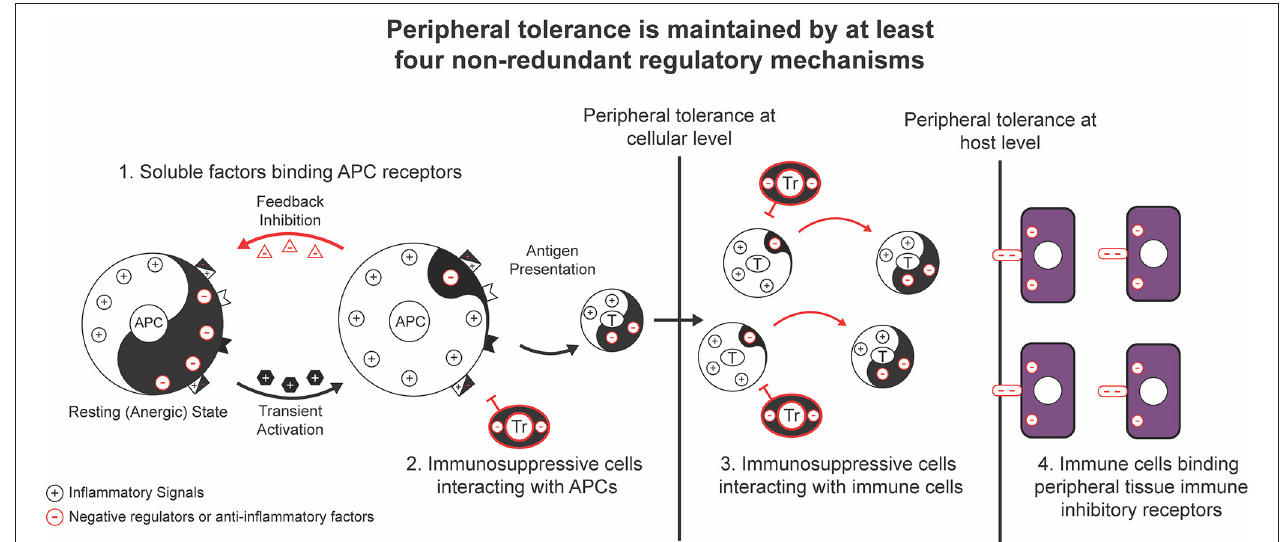
FIGURE 5 | Maintenance of peripheral tolerance at cellular and host levels. Peripheral tolerance is first maintained by individual immune cells using a network of negative regulators [Yin (–)], including negative regulators of inflammatory signaling, soluble anti-inflammatory factors, inhibitory surface receptors and ligands, and regulatory cell subsets, to set up a threshold of stimulatory signaling and keep individual immune cells in an immature or a resting (anergic) state. After activation by proinflammatory stimuli [Yang ( + )] that exceed a threshold level, the inducible feedback negative regulators only allow the transduction of transient stimulatory signals, so that temporarily activated immune cells will quickly shift to a post-activation effector state. Peripheral tolerance is also maintained at the host level by an additional network of negative regulators, including inhibitory surface receptors on peripheral tissues and Foxp3 + T reg cells. The balanced outcome of the proinflammatory signals mediated by pathogens and negative regulators at both the cellular and host levels results in an appropriate immune response that is sufficient to clear pathogen-infected cells, but insufficient to cause acute innate immune toxicity and autoimmune pathologies to normal cells.